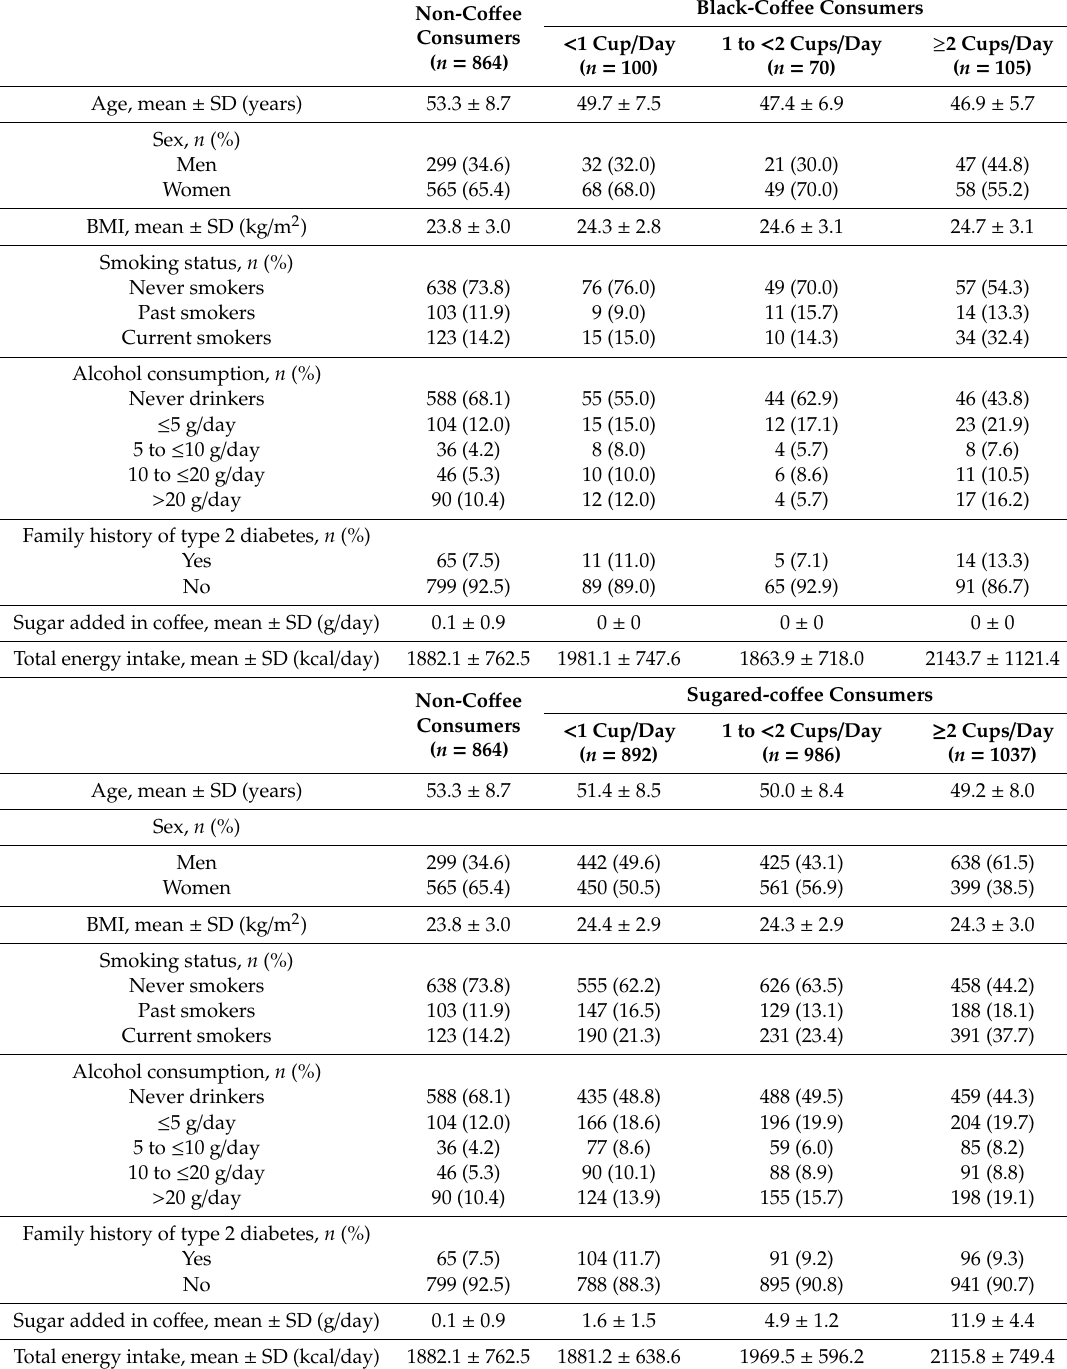
Table 1. Baseline characteristics of study population according to habitual co ff ee